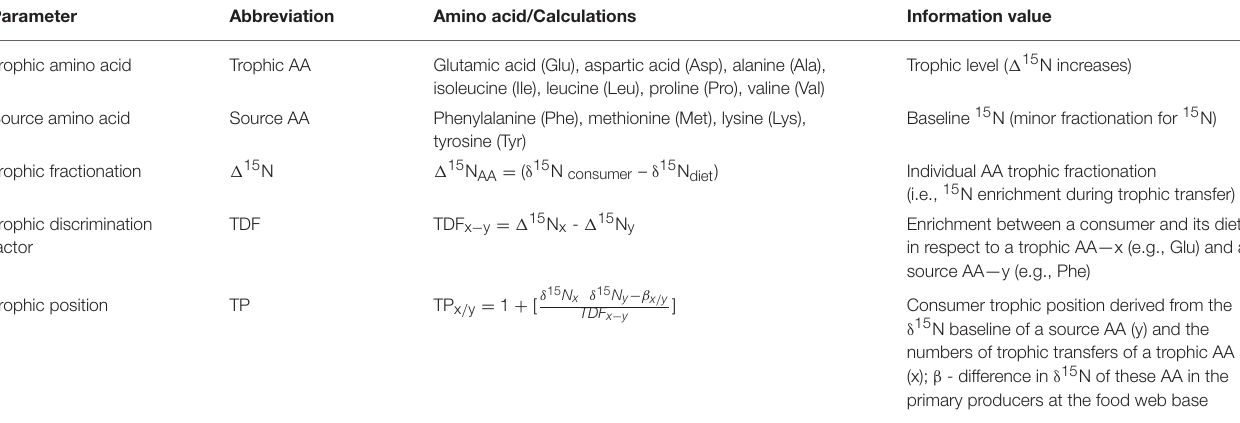
TABLE 3 | “Trophic” and “source” amino acids, fractionation factors, and formula used in in food web studies (Modified after McMahon and McCarthy,